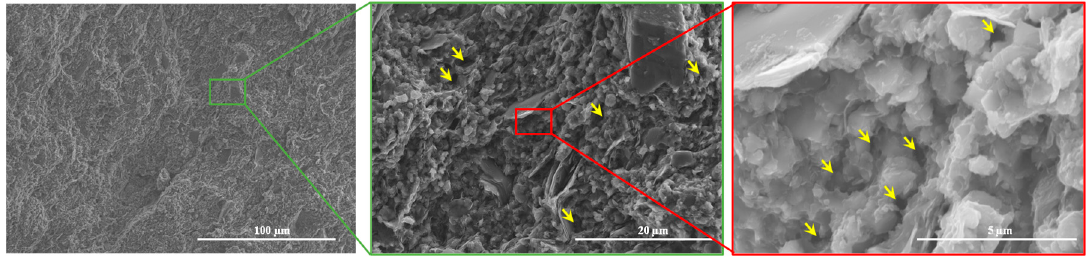
Figure 8. Pores in the sample #16 after the experiment.